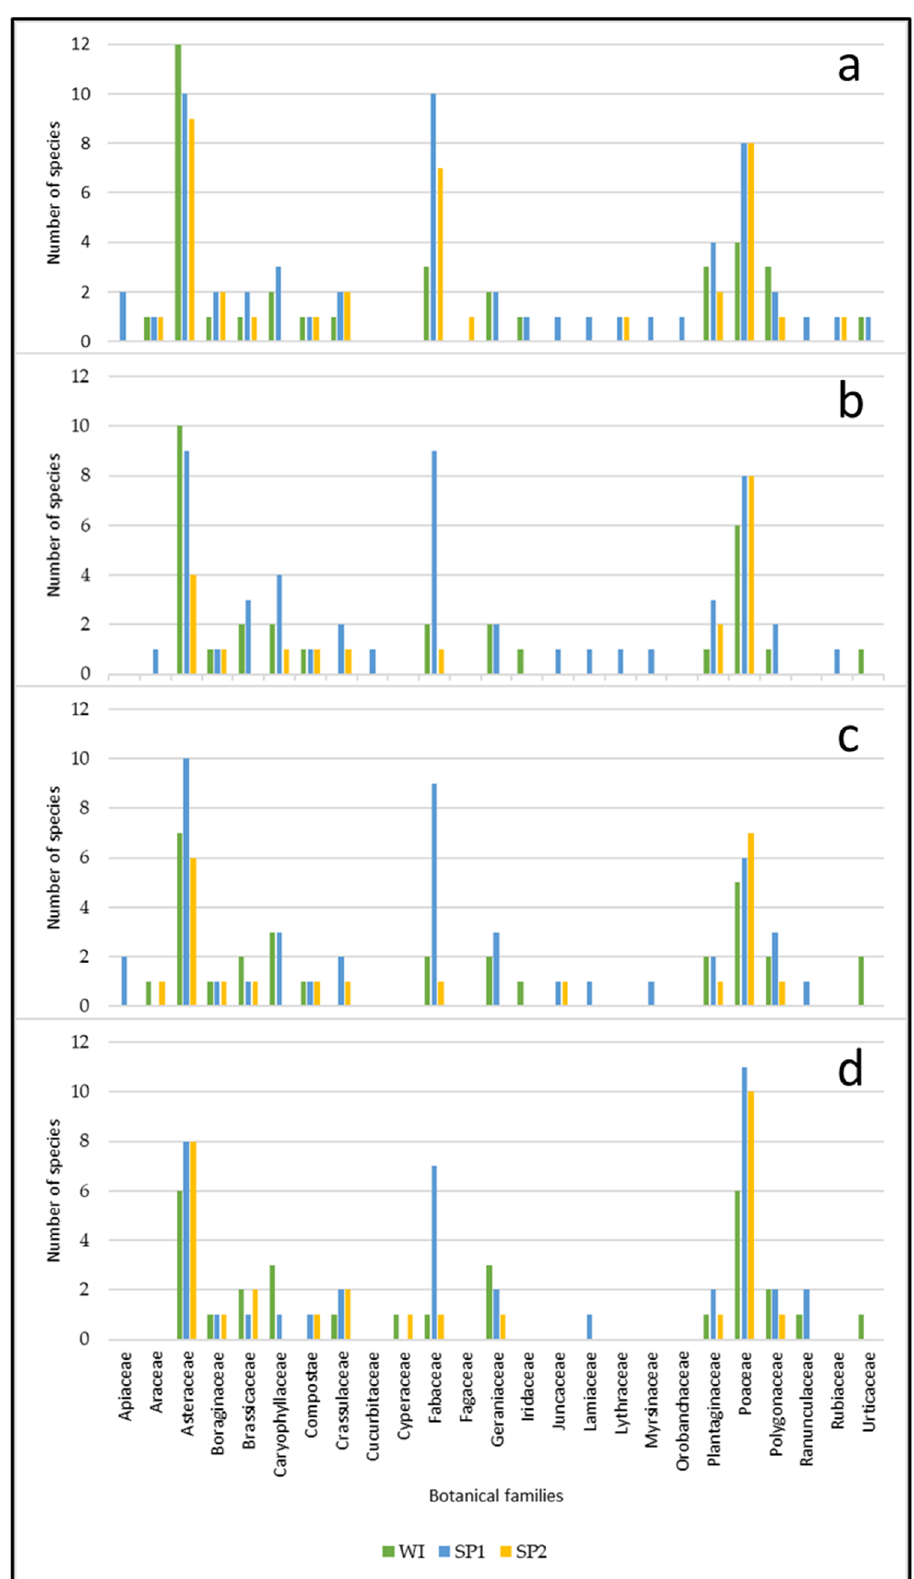
Figure 8. Number of plant species per family for P1UC ( a ), P2UD ( b ), P3TD ( c ) and P4TC ( d ) in WI, SP1, SP2.